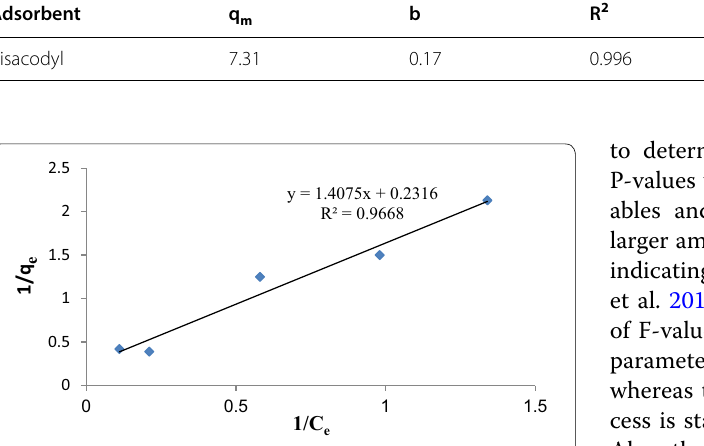
Fig. 5 Langmuir isotherm model for bisacodyl adsorption by mesoporous silica, the experiments were performed in the initial concentration of 5, 25, 50 mg/l, contact time of 18 h and pH of 7. The results were well fitted (R 2 0.967) and showed the model’s = prediction for removal of bisacodyl by mesoporous